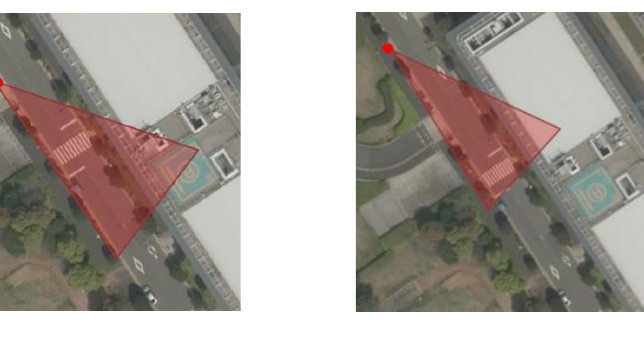
Figure 2. Vehicle and Wizard of Oz method.